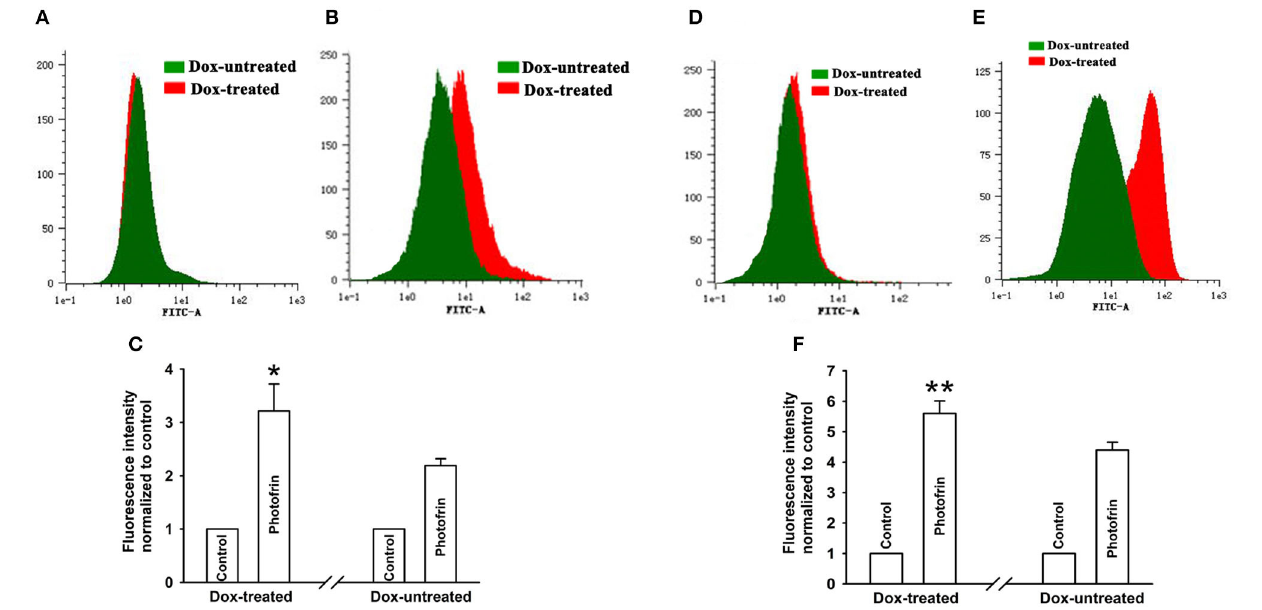
FIGURE 5 | Ca 2 + release and influx were increased by Cx40-formed channels. After incubation with Fluo-3-Am, Dox-treated and Dox-untreated cells were irradiated with or without Photofrin. Flow cytometry was performed to measure the fluorescence intensity of Ca 2 + after PDT. (A) control; (B) 2.5 mg/mL Photofrin; (C) The fluorescence intensity of Ca 2 + . For (A–C) , the cells were incubated in fresh BBS in the absence of Ca 2 + during irradiation. (D) control; (E) 2.5 mg/mL Photofrin; (F) The fluorescence intensity of Ca 2 + . For (D–F) , the cells were incubated in fresh BBS in the presence of Ca 2 + during irradiation. Data points are mean ± SD from 3 experiments. t- test was used to assess statistically significant differences between groups. * P < 0.05, ** P < 0.01, significantly different from Dox-untreated group.